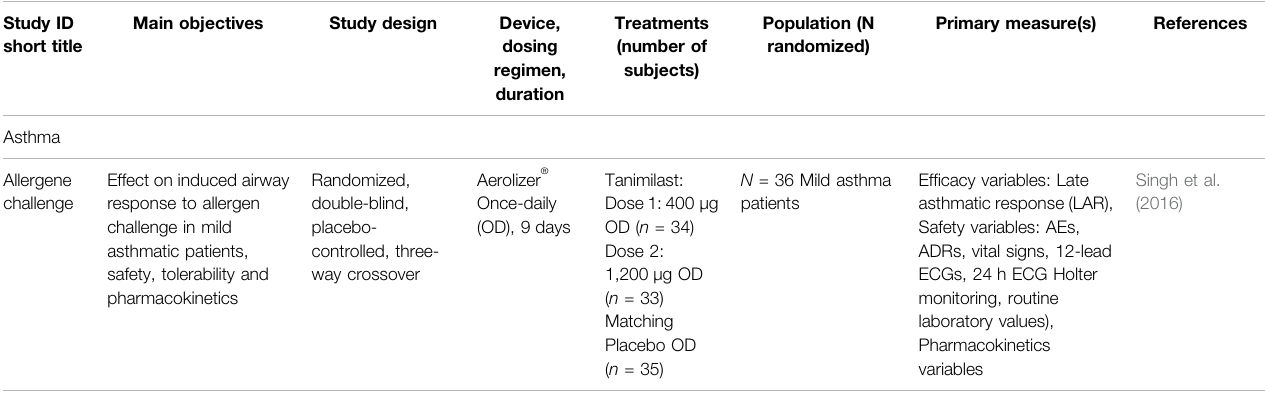
TABLE 4 | Phase IIa